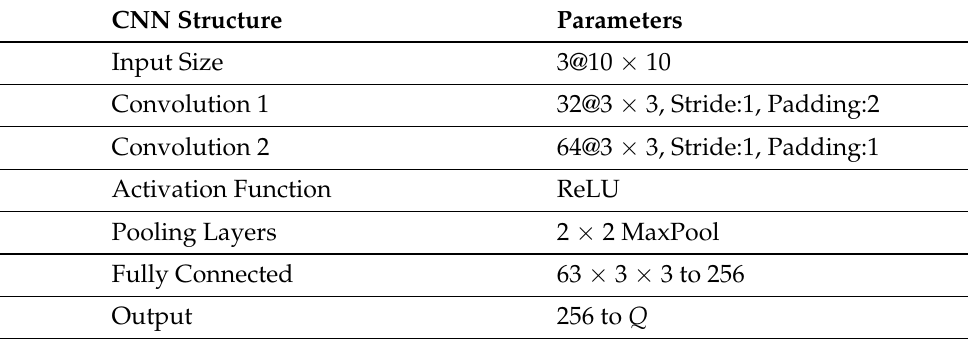
Table 5. Specific relevant parameters of each layer in the